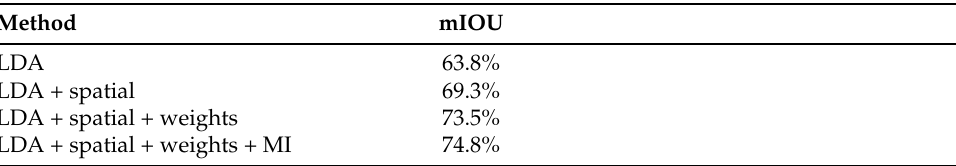
Table 3. Ablation study results on coral images test